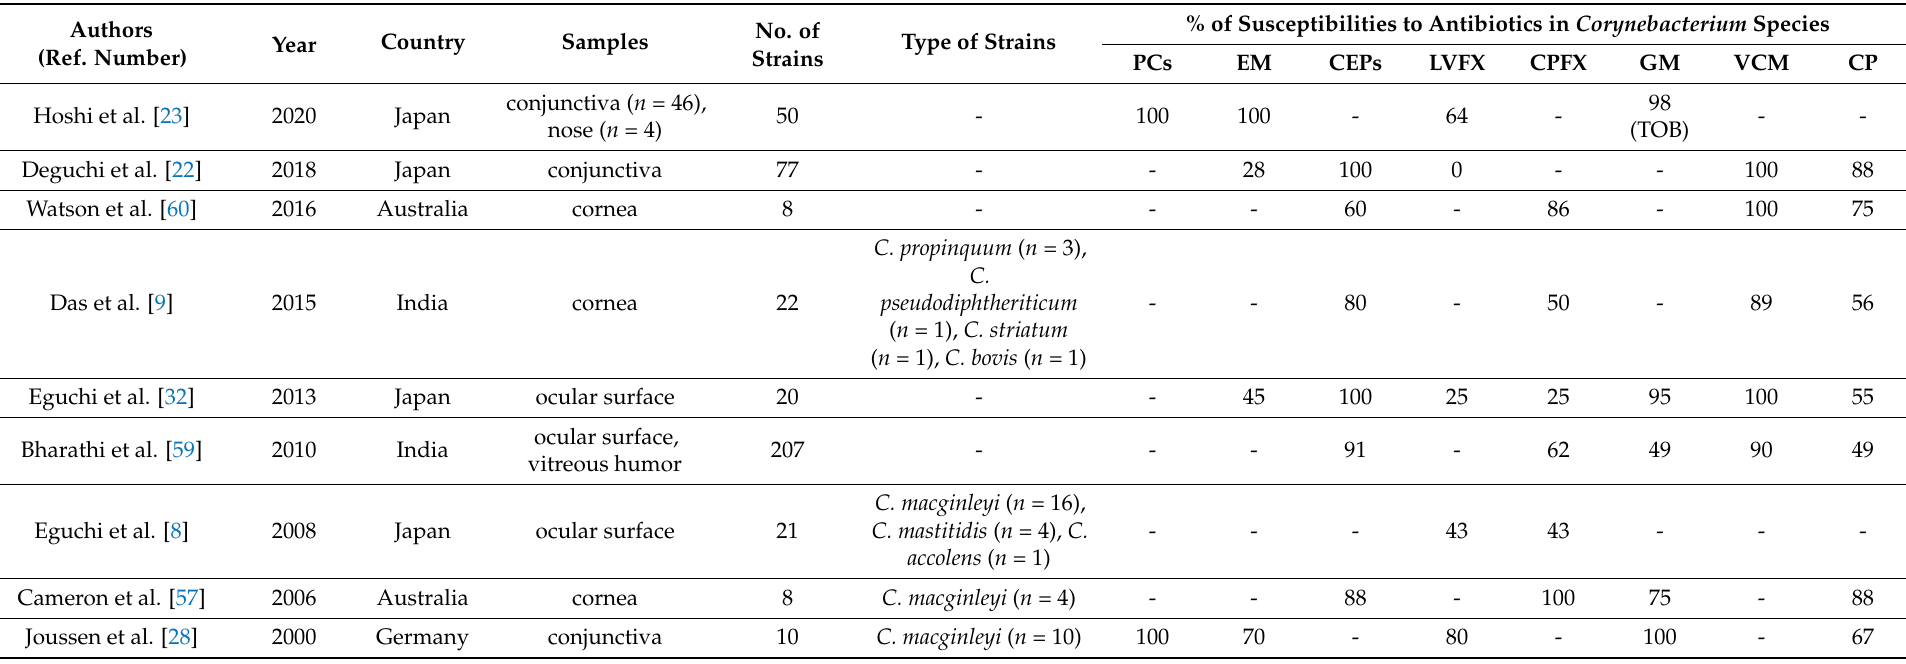
Table 2. Antibiotic susceptibilities of Corynebacterium species in clinical